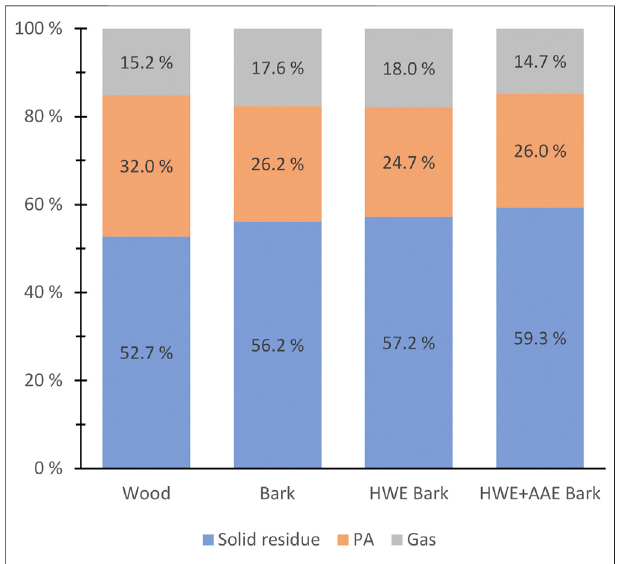
FIGURE 4 | Solid pyroligneous acid (PA) and gaseous product yields (weight percent of feedstock dry weights) produced by torrefaction from hybrid aspen wood, bark, and pre-extracted bark